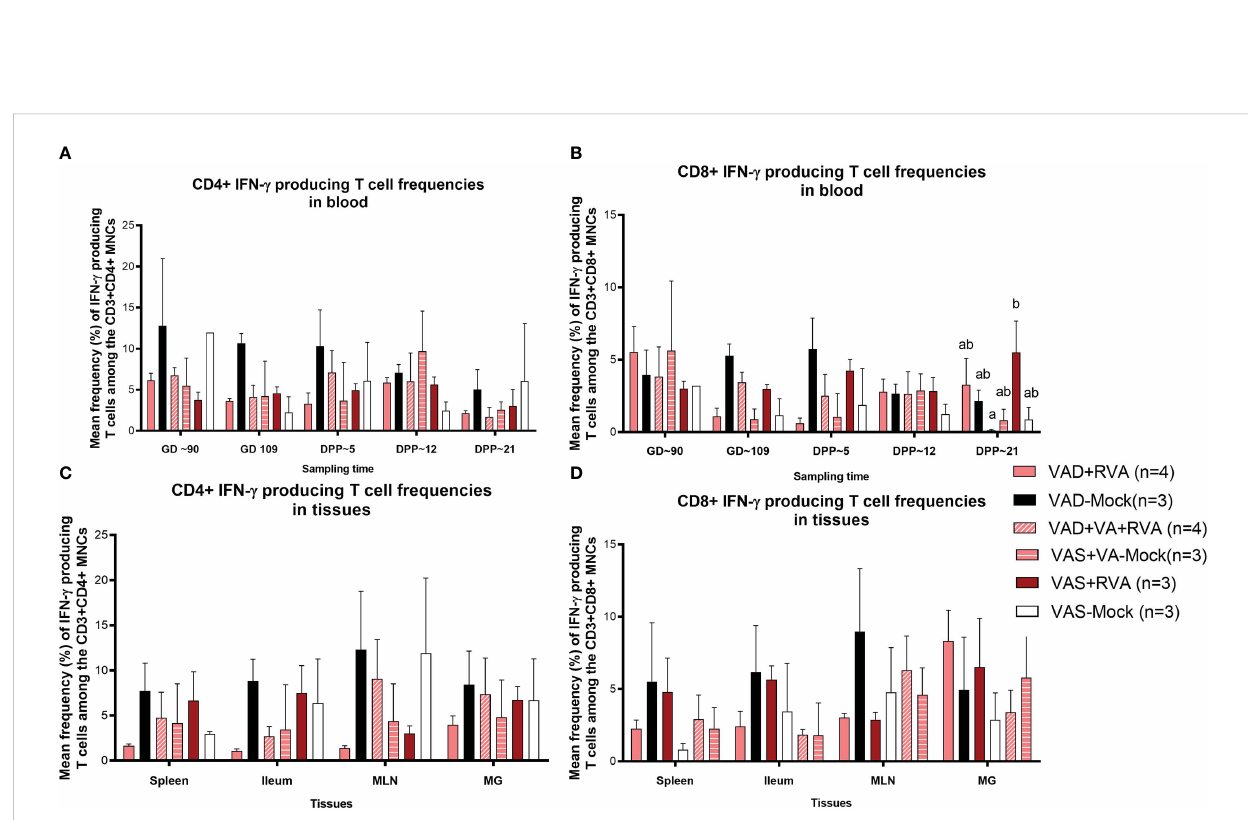
FIGURE 7 Analysis of RVA-speci fi c IFN- g secreting T cells by fl ow cytometry. Mononuclear cells were restimulated with RVA virus in vitro. (A) Mean frequencies of RVA-speci fi c IFN- g producing CD4 + T cells among CD3 + CD4 + T cells in blood mononuclear cells. (B) Mean frequencies of RVA-speci fi c IFN- g producing CD8 + T cells among CD3 + CD8 + T cells in blood mononuclear cells. (C) Mean frequencies of RVA-speci fi c IFN- g producing CD4 + T cells among CD3 + CD4 + T cells in tissue mononuclear cells (D) Mean frequencies of RVA-speci fi c IFN- g producing CD8 + T cells among CD3 + CD8 + T cells in tissue mononuclear cells. Letters a and b indicate signi fi cant differences among treatment groups (mean ± SEM) at each time point. Statistical analysis was performed using two-way ANOVA with repeated measures and Tukey-Kramer test for multiple comparisons, P ≤ 0.05. (GD, gestation day; DPP, day post-partum; VAD, vitamin A de fi ciency; VAS, Vitamin A suf fi cient; VA-vitamin A).